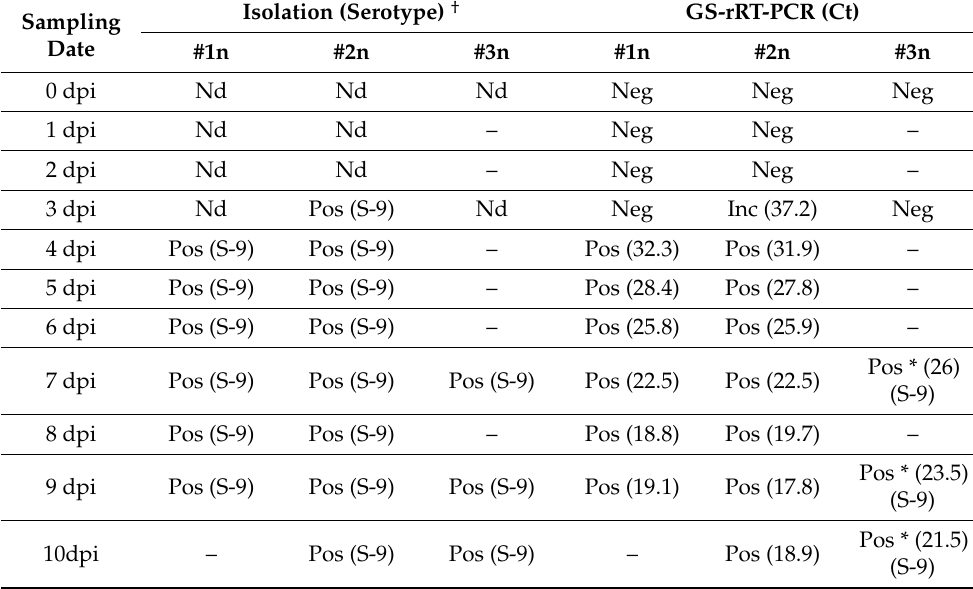
Table 3. Comparative AHSV detection in EDTA blood samples of unvaccinated horses (#1n, #2n, and #3n).